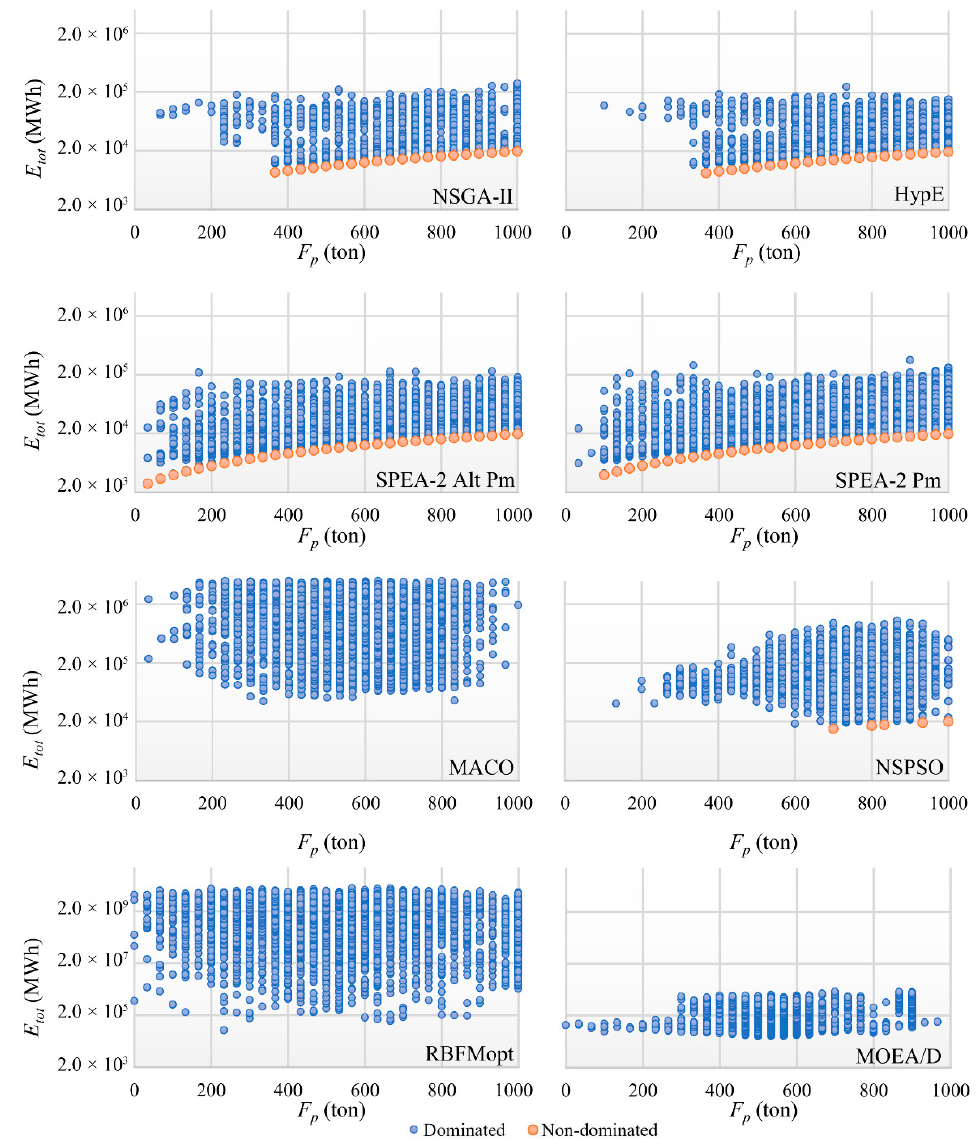
Figure 23. Search space and optimisation results of multi-objective algorithms.